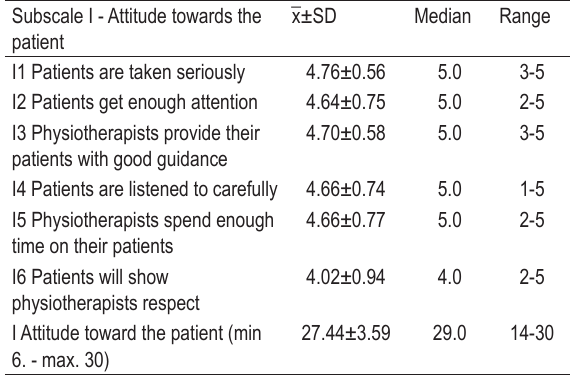
TABLE 2. Overview of mean scores – subscale I - Attitude towards